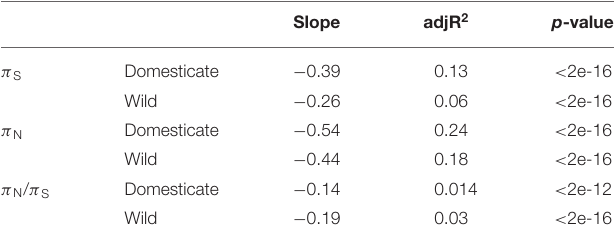
TABLE 2 | Correlations of polymorphism estimates and expression levels. Slope adjR 2 p